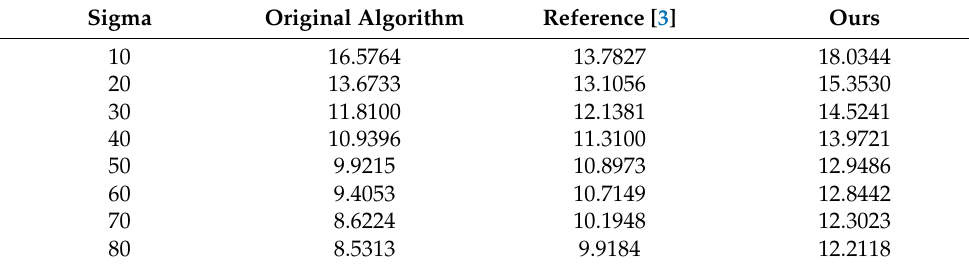
Table 5. PSNR of the three algorithms for the Monarch image.